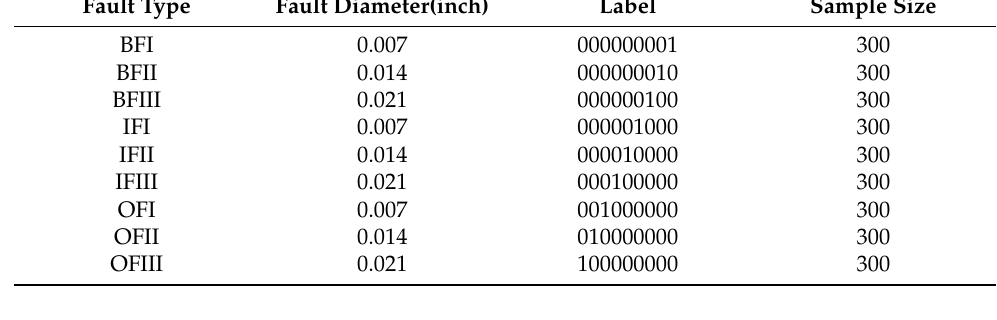
Table 3. Status information of 9 types of fault.